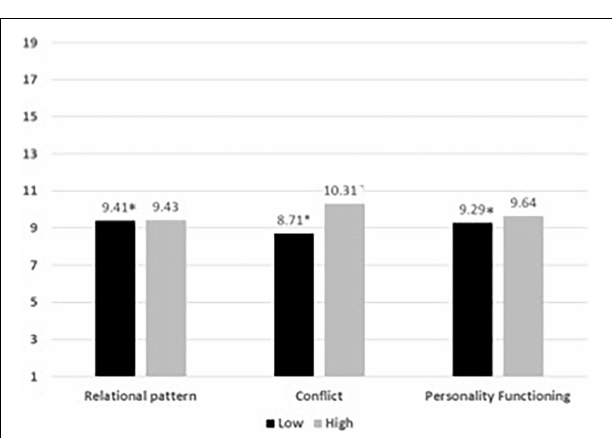
FIGURE 3 | Average of the level of complexity of patients’ change and the high or low presence of each focus on the whole process. ∗ p < 0.05.